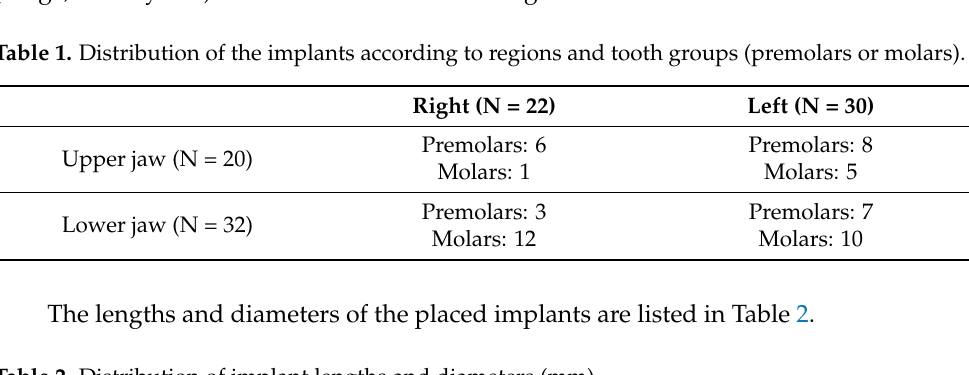
Table 2. Distribution of implant lengths and diameters (mm).